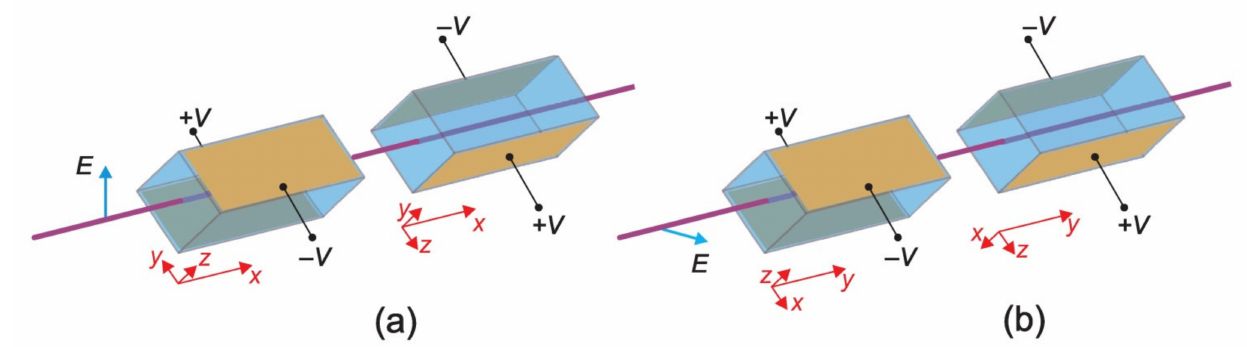
Figure 1. Double-crystal thermal compensation schemes for KTP and RTP PCs: ( a ) X-cut, ( b ) Y-cut. Arrows near the electrical field E indicate the input light polarization. Vertical ( a ) and horizontal ( b ) directions of E are shown as